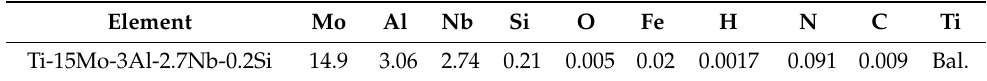
Table 1. Chemical constituents of Ti-15Mo-3Al-2.7Nb-0.2Si alloy (wt.%.).